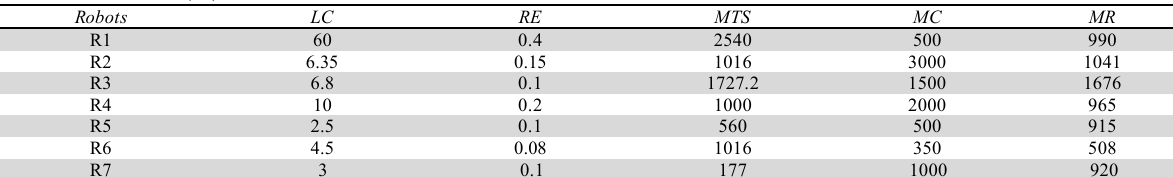
Decision Matrix (D)